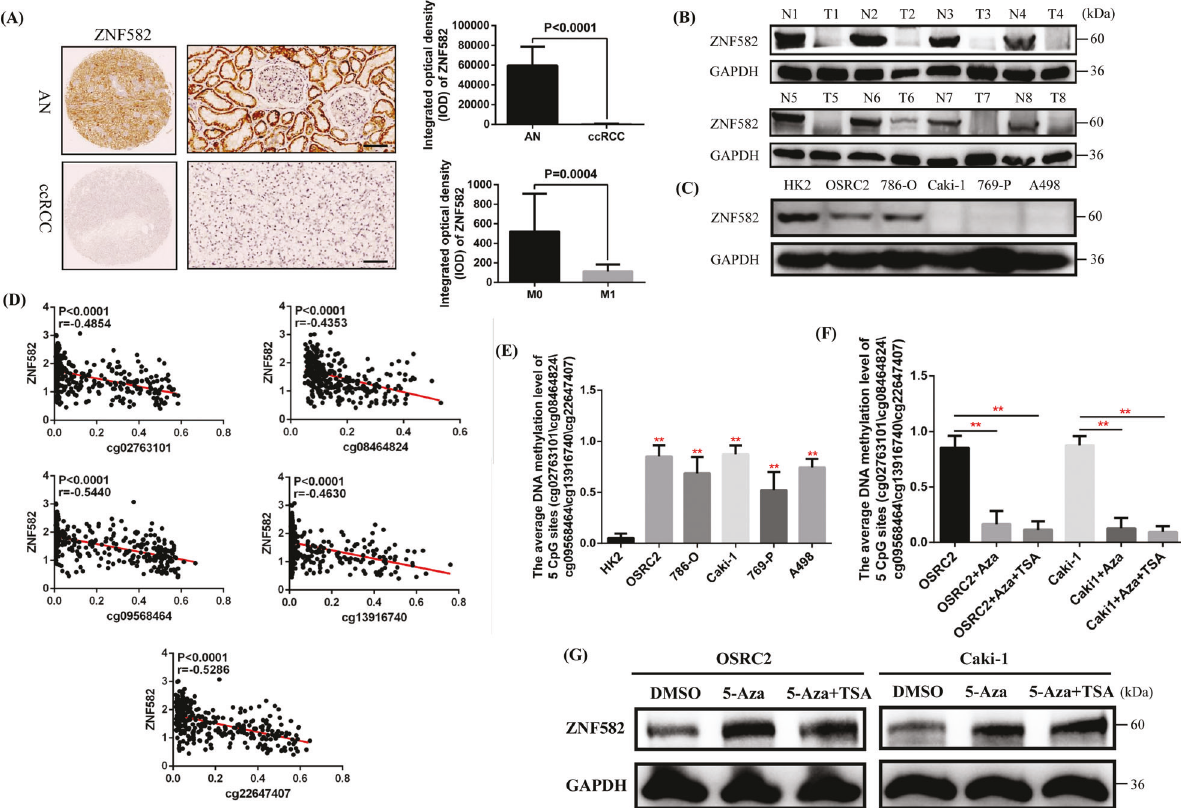
Fig. 1 ZNF582 expression is underexpressed in ccRCC and negatively regulated by DNA methylation. A Comparison of ZNF582 protein expression in the paraf fi n sections of 60 pairs of ccRCC and AN (adjacent normal renal) tissue using Immunohistochemistry. IOD: integrated optical density. Bar: 25 um (400X). B Comparison of ZNF582 protein expression in eight pairs of fresh ccRCC and AN tissue using Western Blot (N: adjacent normal renal tissue, T: tumor tissue). C Detection of ZNF582 protein expression in fi ve ccRCC cell lines (OSRC2, 786-O, Caki-1, 769- P and A498) and a relative control cell line (HK2) using Western Blot. D Correlation between ZNF582 mRNA expression and the methylation level of its fi ve CpG sites based on TCGA-KIRC data. E The average methylation levels of these fi ve CpG sites in OSRC2, 786-O, Caki-1, 769-P, A498 and HK2 cell lines using Massarray DNA methylation assay; ** P < 0.01, vs. HK2. F The average methylation levels of these fi ve CpG sites in OSRC2 and Caki-1 cells after treatment with 5-aza-dC and TSA demethylated ZNF582. G The protein expression level of ZNF582 in OSRC2 and Caki-1 cells after treatment with 5-aza-dC and TSA demethylated ZNF582. All result data are represented as mean ± SEM. ** P < 0.01, compared with the corresponding experiment are used to detect the effect of ZNF582 over- expression on ccRCC cell growth. Immuno fl uorescence TUNEL method is used to detect the effect of ZNF582 overexpression on ccRCC cell apoptosis. Wound healing assay and cell migration and invasion experiments are used to detect the effect of ZNF582 overexpression on the metastatic ability of ccRCC cells. Our results veri fi ed that ZNF582 overexpression signi fi cantly suppresses growth and promotes apoptosis of OSRC2 and Caki-1 cells (Fig. 2A – C). Moreover, compared with control cells, the number of OSRC2 and Caki-1 cells that migrated and invaded after ZNF582 overexpression is also signi fi cantly reduced (Fig. 2D – F). ZNF582 protein binds to TJP2 and ERK2 proteins and regulates their expression In order to explore the potential mechanism by which ZNF582 overexpression inhibits the growth and metastasis of ccRCC cells, TMT quantitative proteomics method was used to detect the differentially expressed proteins between ZNF582 overexpression OSRC2 cells and control cells. TMT data analysis results showed that 964 proteins and 799 proteins are up-regulated and down- regulated in ZNF582 overexpression OSRC2 cells compare with control cells, respectively (Fig. 3A). Co-IP experiment was used to identify proteins that may bind to ZNF582, and silver-staining method was utilized to detect the differential protein bands